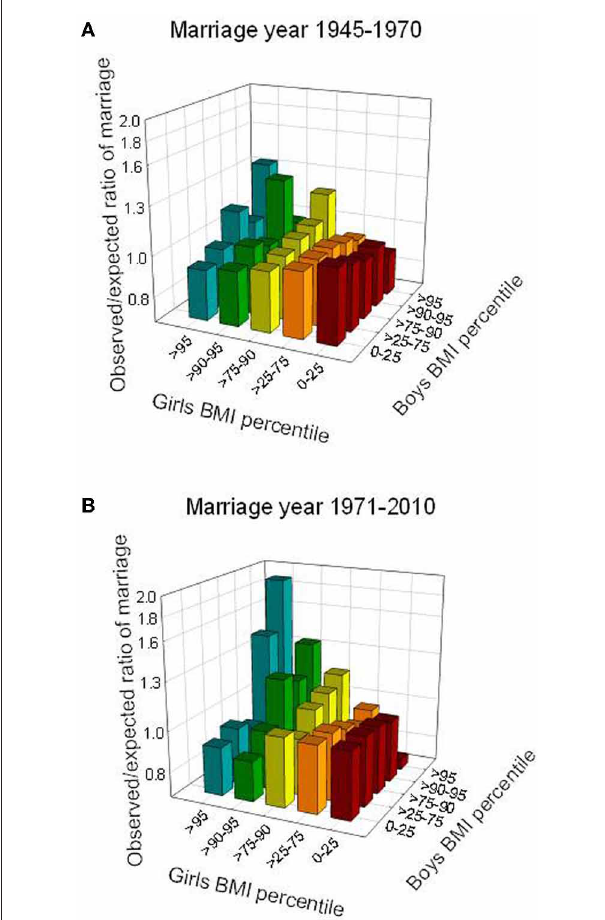
FIGURE 3 | Observed compared to expected ratios of marriage (log scale) according to group-based BMI z -scores at age 13 years, shown for two marriage periods, prior to (A) and during (B) the obesity epidemic. Ratio = 1 corresponds to random marriage. Pearson’s Chi squared test, p -values; p = 0 . 005 (1945–1970)and p < 0 . 0001 (1971–1989).